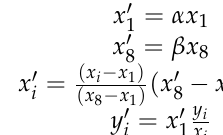
Figure 4. The clustering results of our datasets.